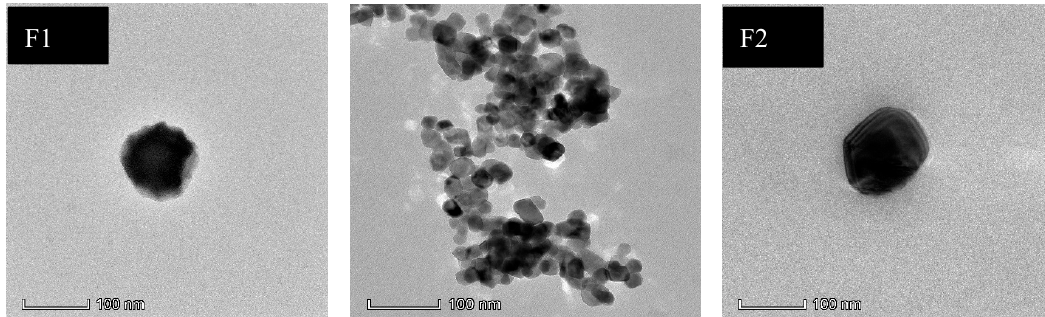
Figure 1. TEM pictographs of different LMW chitosan-curcumin nanoparticles.